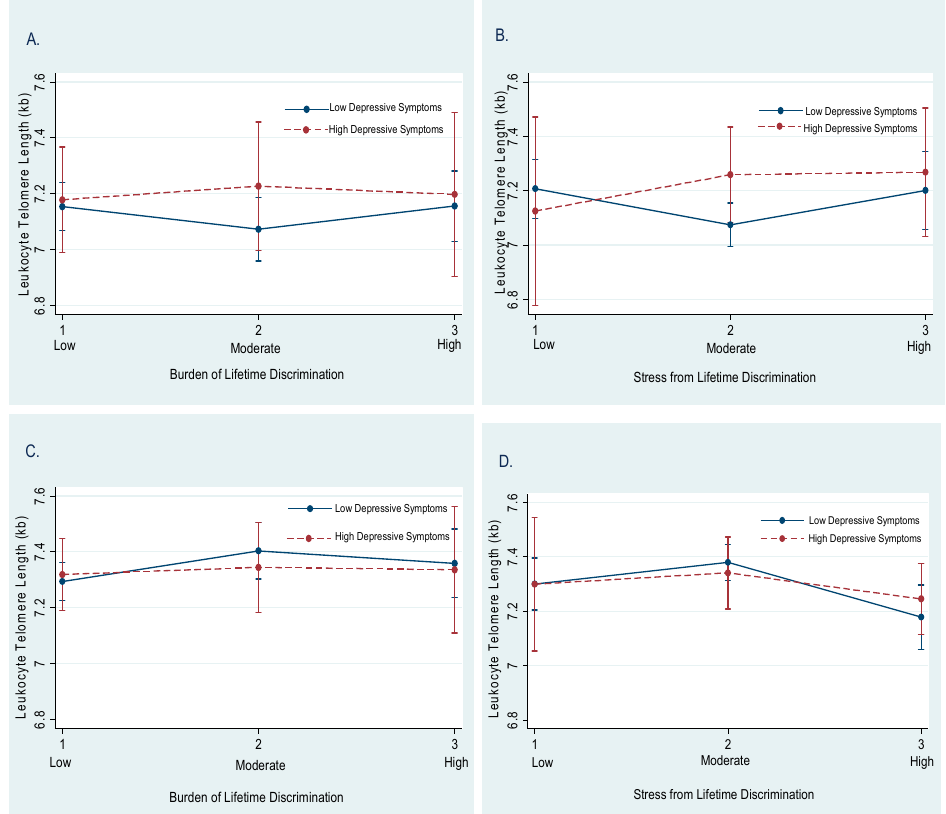
Figure 1. Predicted associations of leukocyte telomere length (LTL) with burden of and stress from lifetime discrimination by depressive symptoms among men ( A , B ) and women ( C , D ) with 95% confidence intervals (Cis), Jackson Heart Study (2000–2004). Note: Models were fully-adjusted for the association of mean differences in LTL at baseline with low, moderate, and high burden of and stress from lifetime discrimination by depressive symptoms. Depressive symptoms were categorized as low (Centers for Epidemiologic Studies-Depression (CES-D) > 16) and high (CES-D score ≤ 16). All predicted models are adjusted for age, education, waist circumference, smoking, and CVD prevalence.